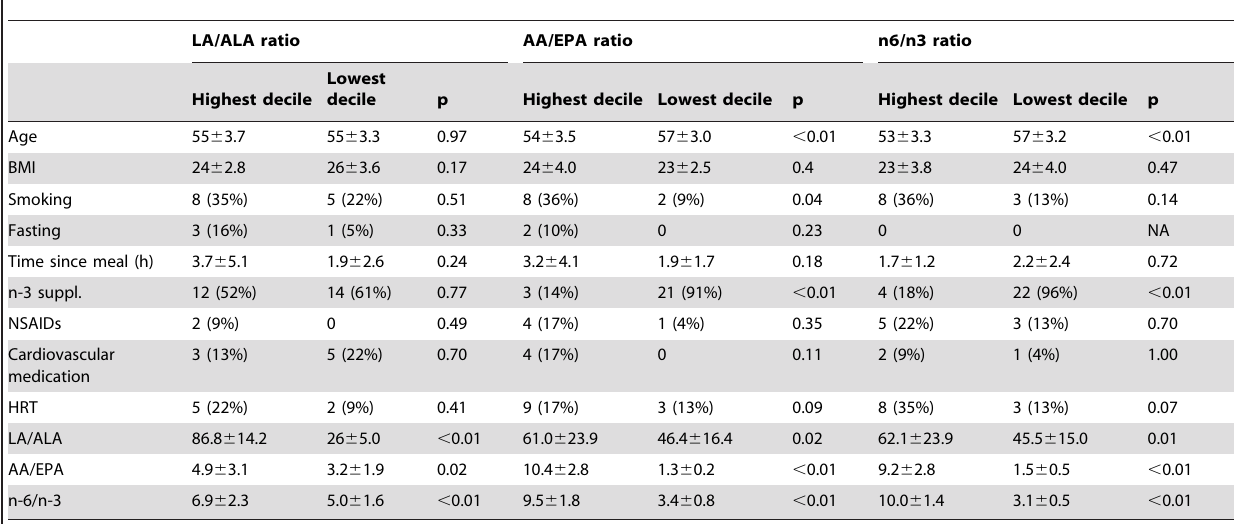
Table 2. Characteristics of the highest and lowest fatty acid ratio deciles a .